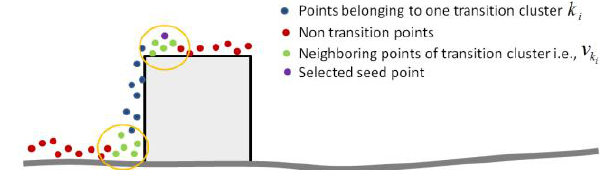
Figure 2: Illustration of seed point selection procedure. Seed point is selected as the highest point among the neighboring points of the transition cluster v i k